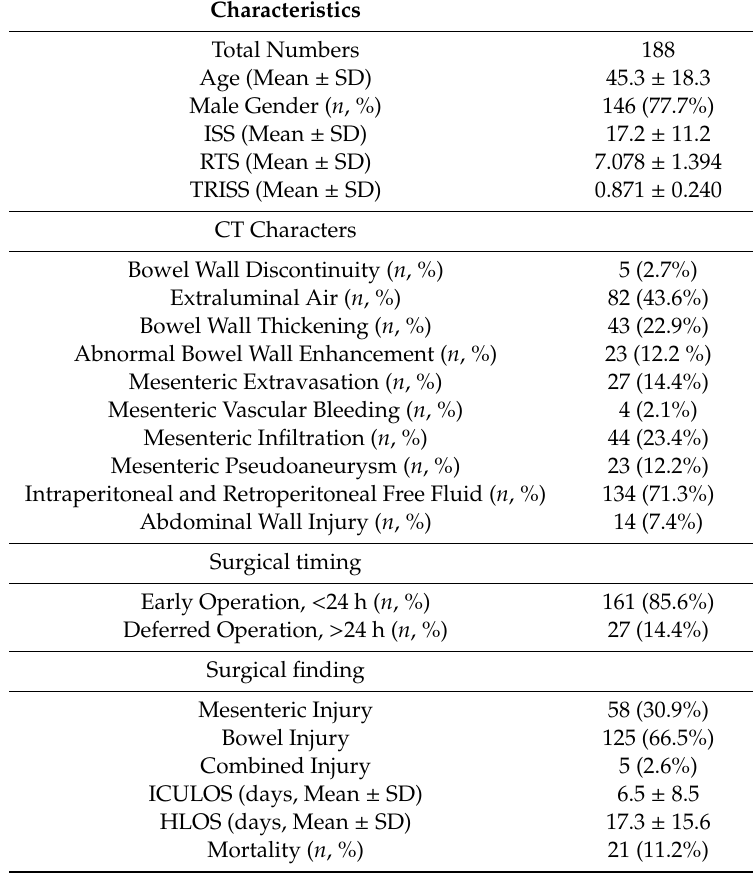
Table 1. The characteristics of patients with blunt bowel and mesenteric